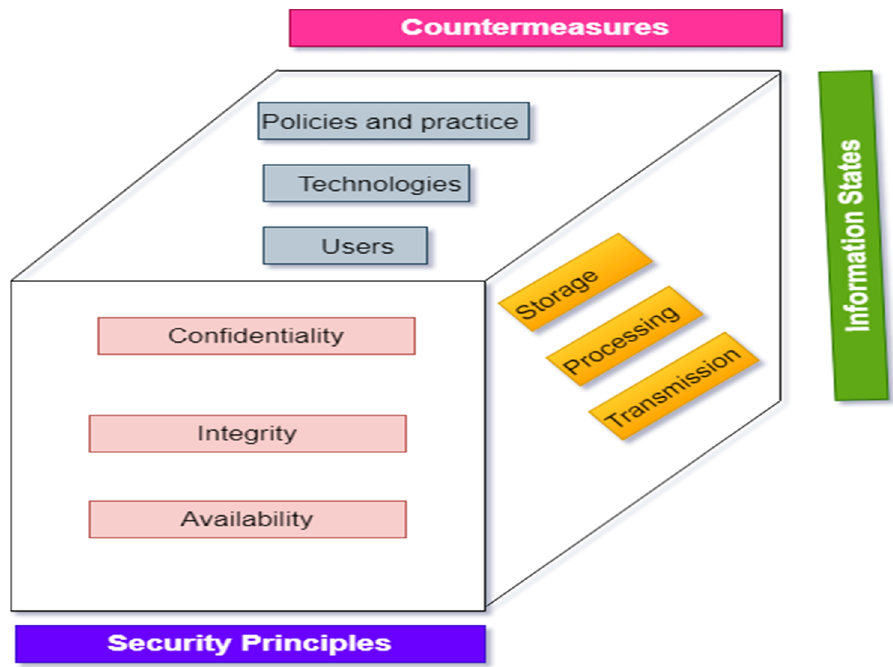
Figure 1. Three dimensions of cyber security.